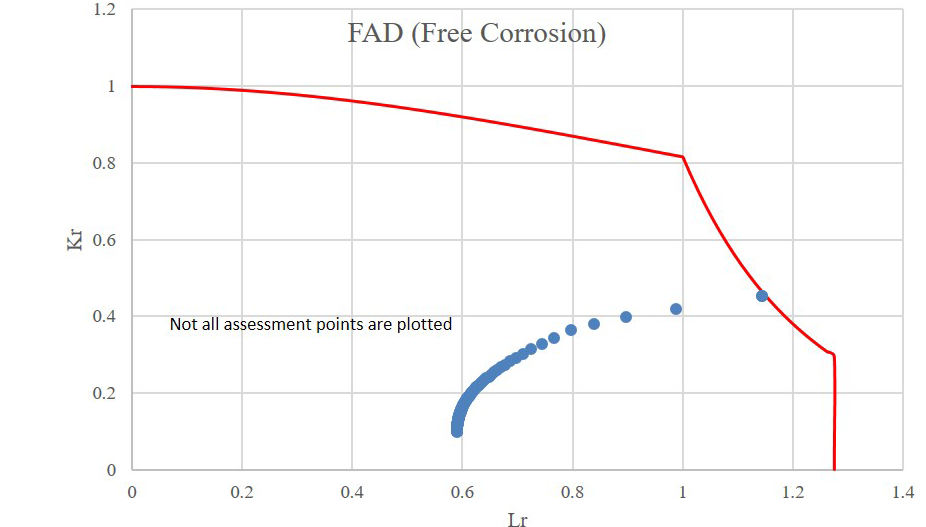
Figure 24. Failure assessment diagram (FAD) for crack growth in HAZ and with free corrosion.